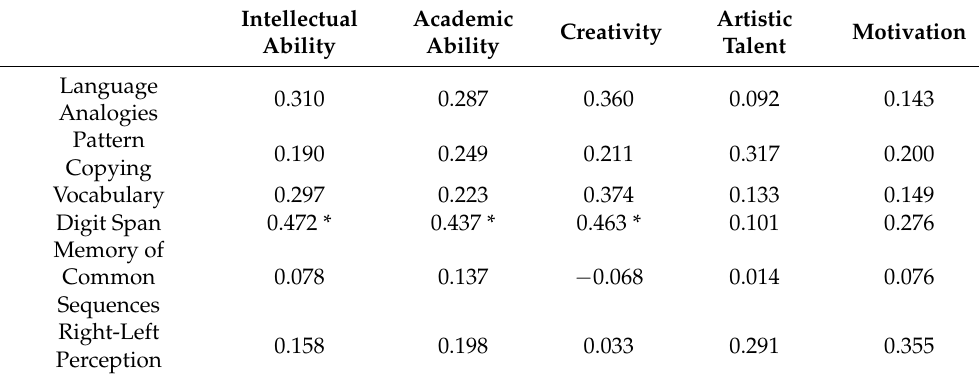
Table 6. Correlations between GRS-P and Athena test